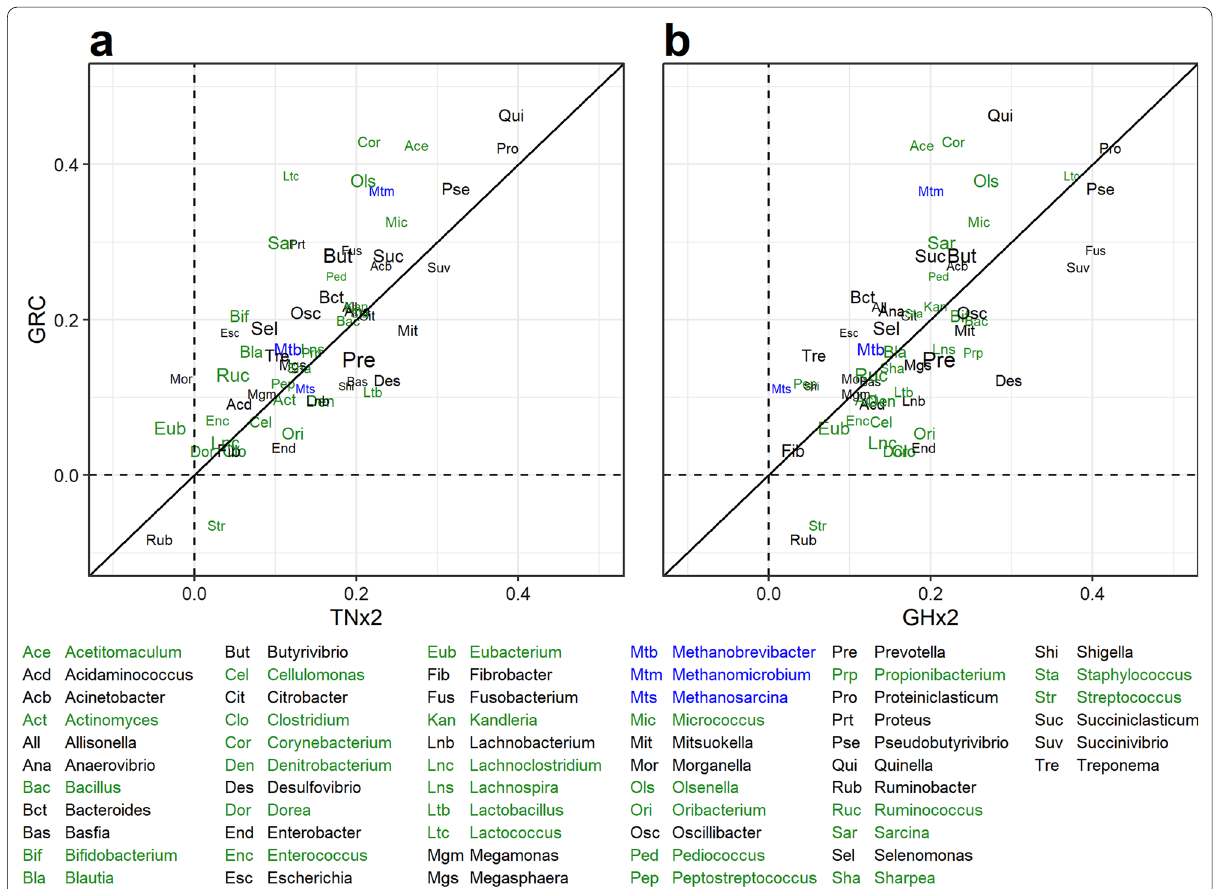
Fig. 7 Correlation of log 10 relative abundance between sampling round 1 and 2 for samples preserved using different methods. a Correlation estimates between rounds for samples preserved using GRC compared to samples preserved using TNx2. b Correlation estimates between rounds for samples preserved using GRC compared to samples preserved using GHx2. Taxon labels are colored according to whether they are archaeal (blue), bacterial with a gram-positive wall (black) or bacterial with a gram-negative wall (green). The size of the taxon labels on the plots